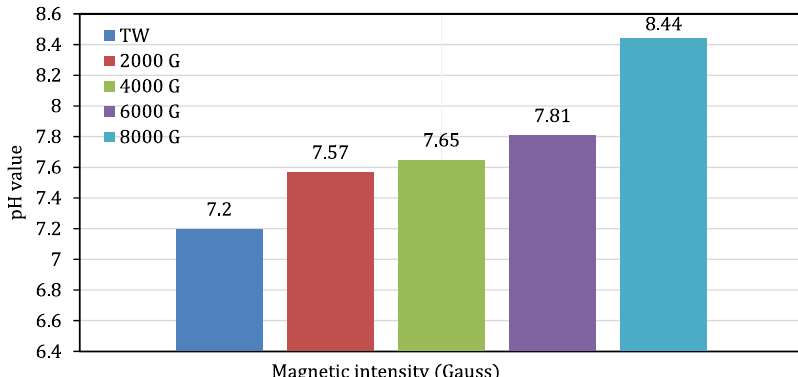
Figure 4: Variation in pH value of water treated with di ff erent magnetic